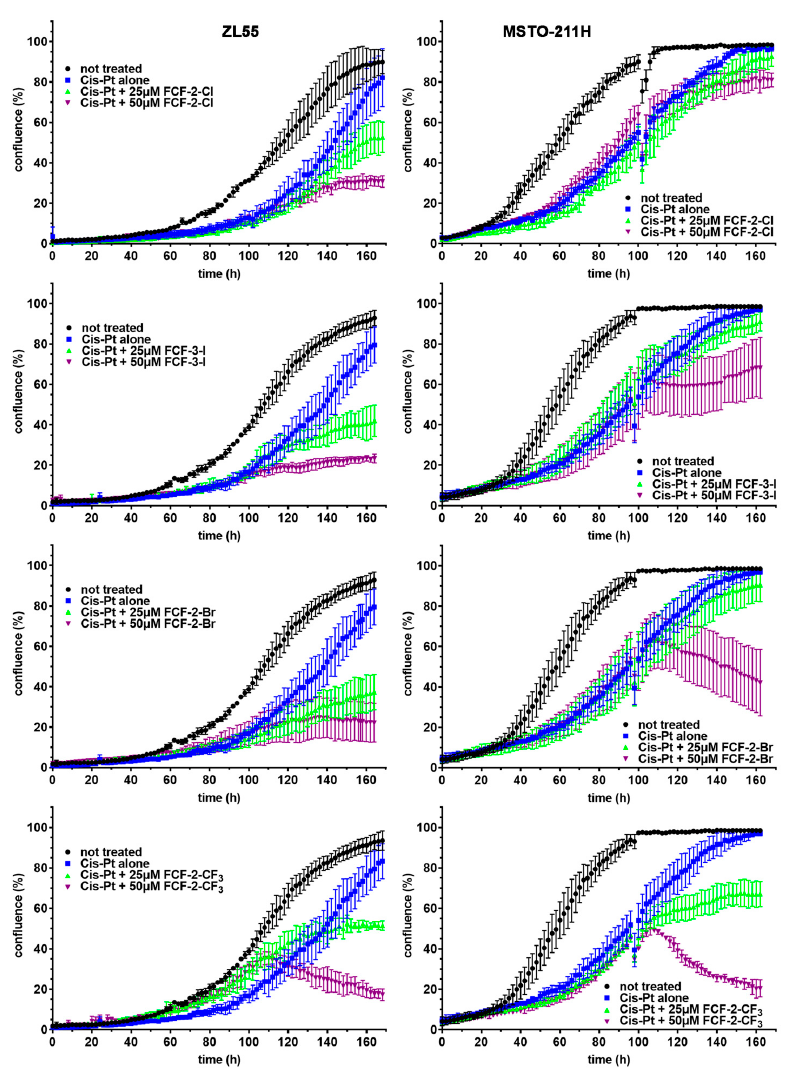
Figure 3. Real-time growth curves of human ZL55 and MSTO-211H cells exposed to cisplatin (Cis-Pt) alone for 96 h, followed by supplemental treatment with FCF-2-Cl, FCF-3-I, FCF-2-Br and FCF-2-CF 3 for an additional 72 h at concentrations of 25 and 50 µM. The representative growth curves of non-treated MM cells are shown in black. A plateau at near 100% confluence is reached at ~100 h in MSTO-211H cells, and at >140 h in ZL55. Treatment with cisplatin (1.25 µM) strongly reduces MTT signals for the first ~60 h. From then on, an increasing number of cisplatin-resistant cells appear. At 96 h, FCF and its three analogs (FCF-3-I, FCF-2-Br and FCF-2-CF 3 ) were added at 25 µM (green curves) and 50 µM (magenta curves), or they were left to grow in the presence of cisplatin only (blue curves). The latter cells reached near-100% confluence at 168 h, while the addition of FCF (and its analogs) decreased the confluence to various extents. The values in the curves represent the mean ± SD from three wells obtained within one experiment. The scattered values at 96 h are the results of the brief removal of the plates from the Incucyte system to add the FCF and its analogs.